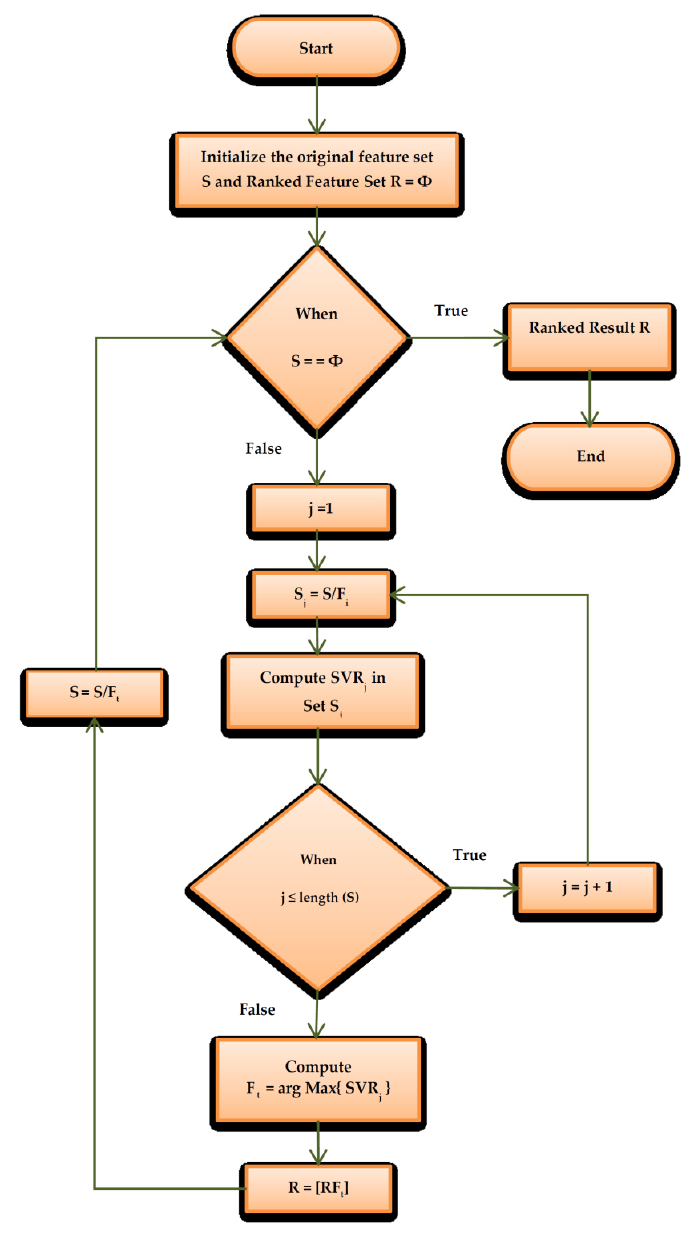
Figure 2. Support vector ratio-based support vector machine recursive feature ranking—flow diagram.